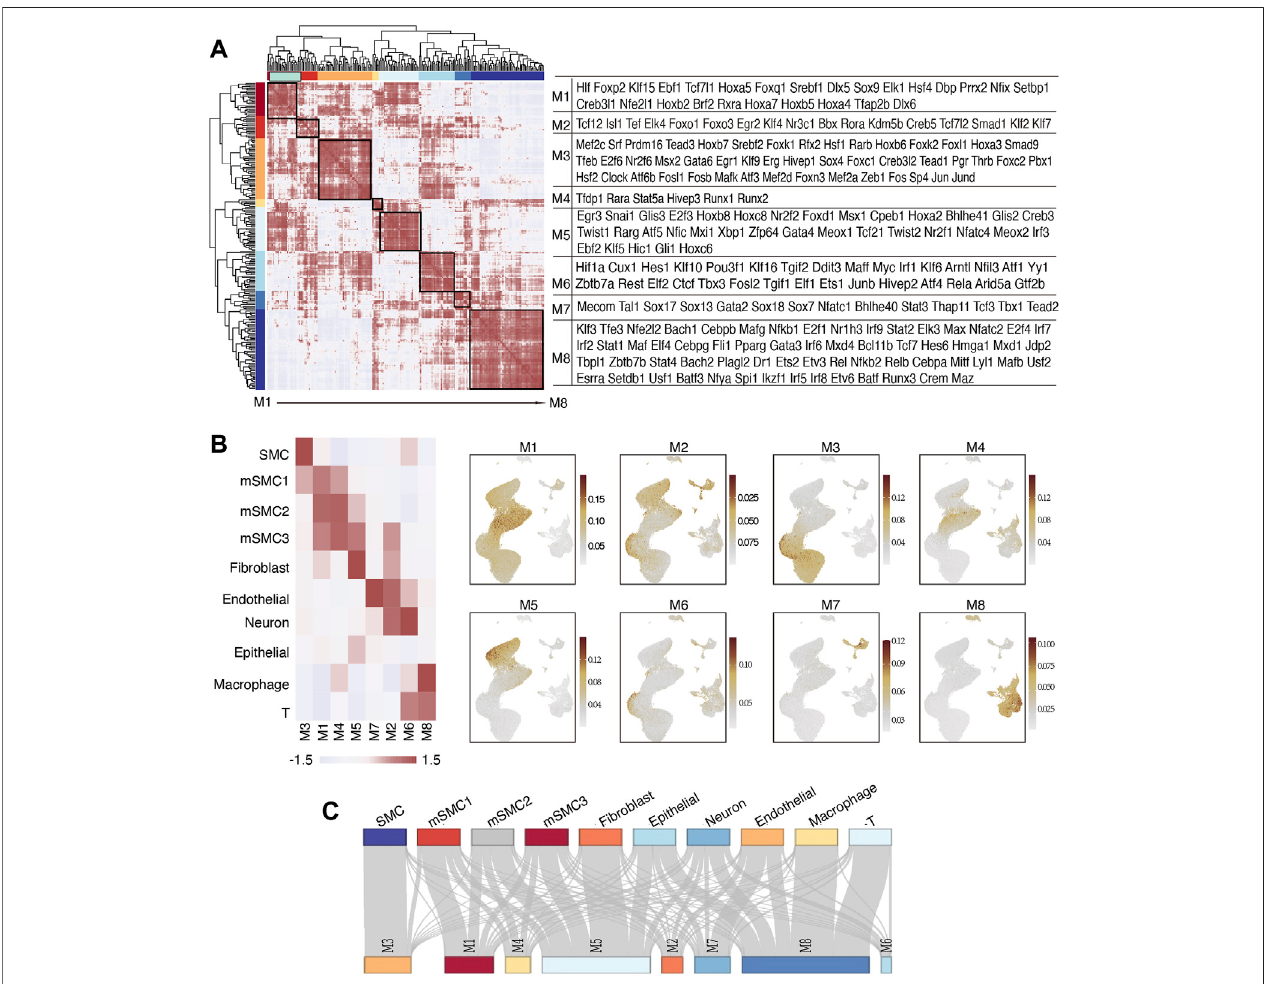
FIGURE 3 | Module analysis of identi fi ed regulons in atherosclerosis in mice. (A) Heatmap displays clustered regulon modules based on the CSI matrix along with theincluded regulonsbeingshown intheright. (B) Heatmap intherightpanelshowstheaverageactivity scoresofeachidenti fi edmoduleineach celltype.Theleftpanel displays the UMAP visualization of the average scores of eight identi fi ed modules in each single cell. (C) Sankey plot demonstrates the distribution pattern of top 20 speci fi c regulons for each cell type in the representative regulon modules. CSI, connection speci fi city